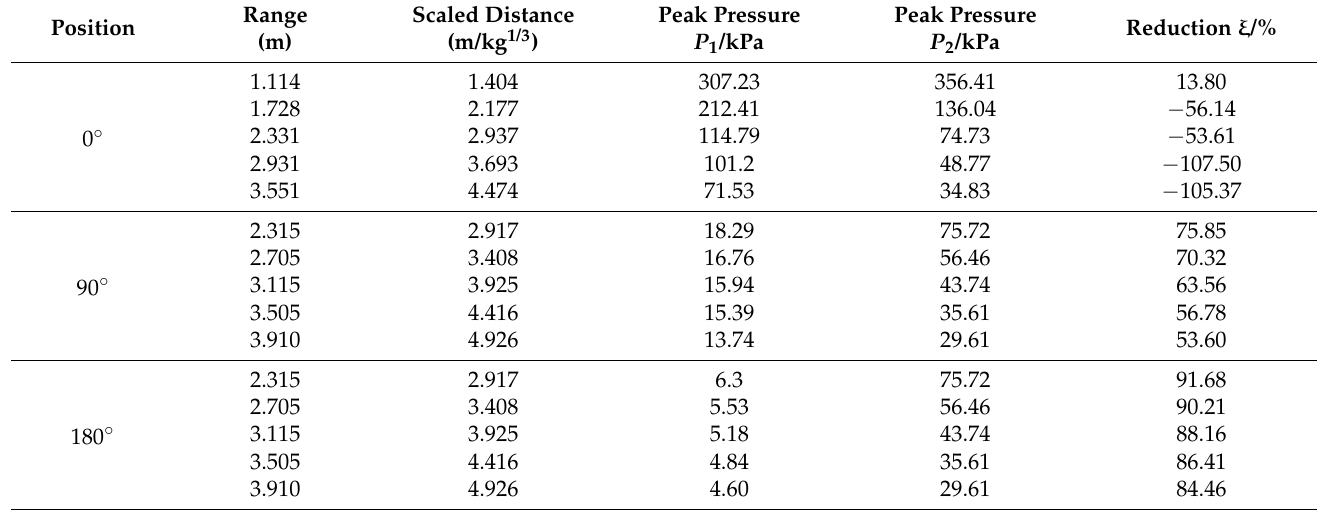
Table 3. Model for overpressure